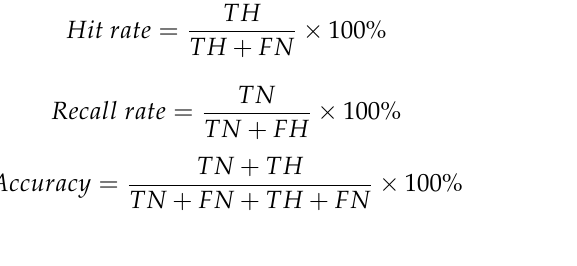
Table 4. Parameters of CVAE.